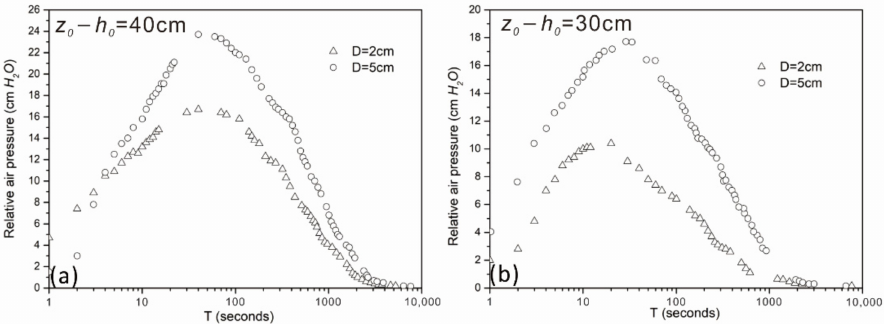
Figure 5. Changes of the positive pressure (PP) with time in water injection